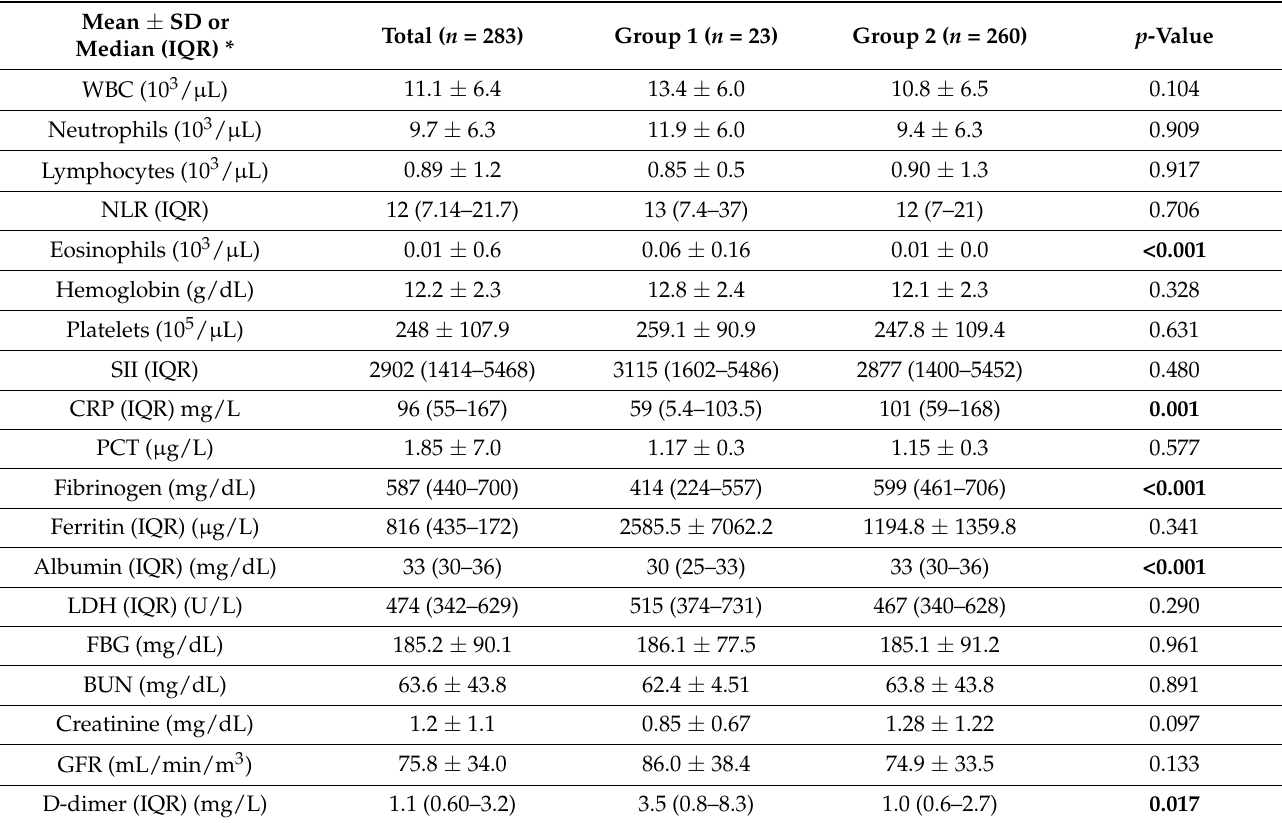
Table 2. Comparison of laboratory characteristics of the groups according to the presence of